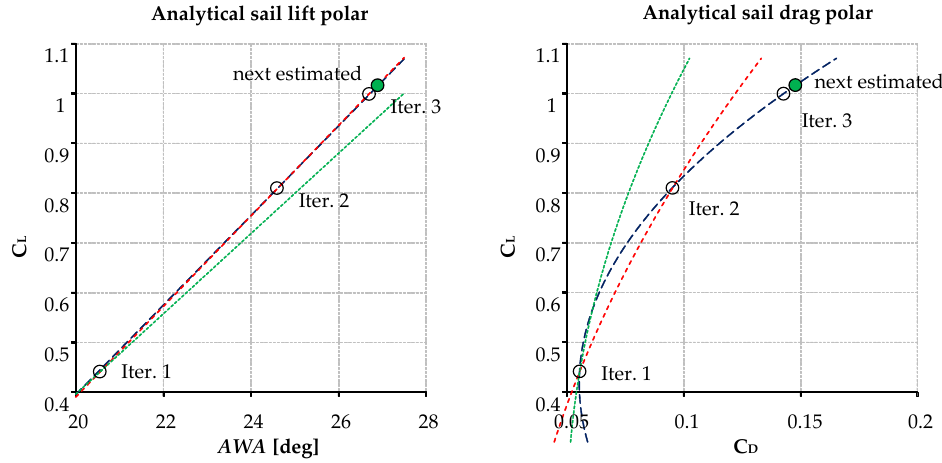
Figure 12. Example of sail analytical polars computation progress.